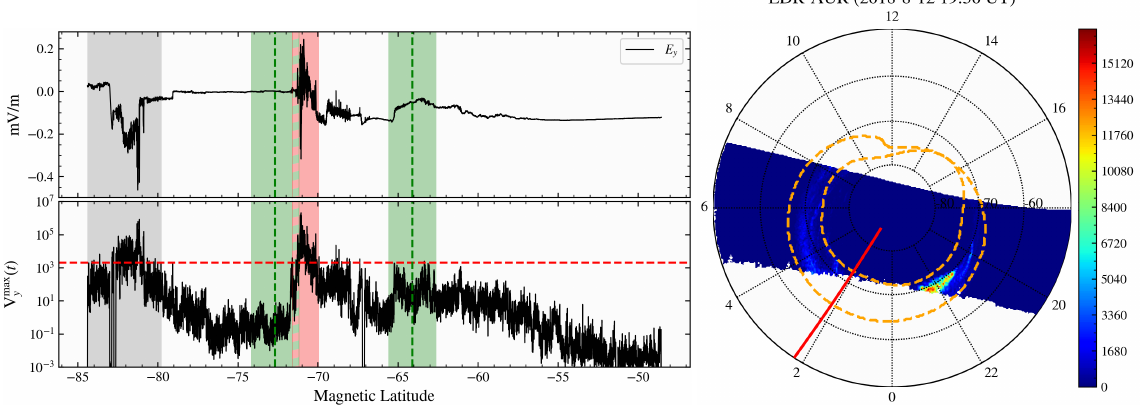
Figure 16. Same as Figure 8, except for orbit 2912. Positive detection of activity at the northward AO boundary with quiet interval in the polar